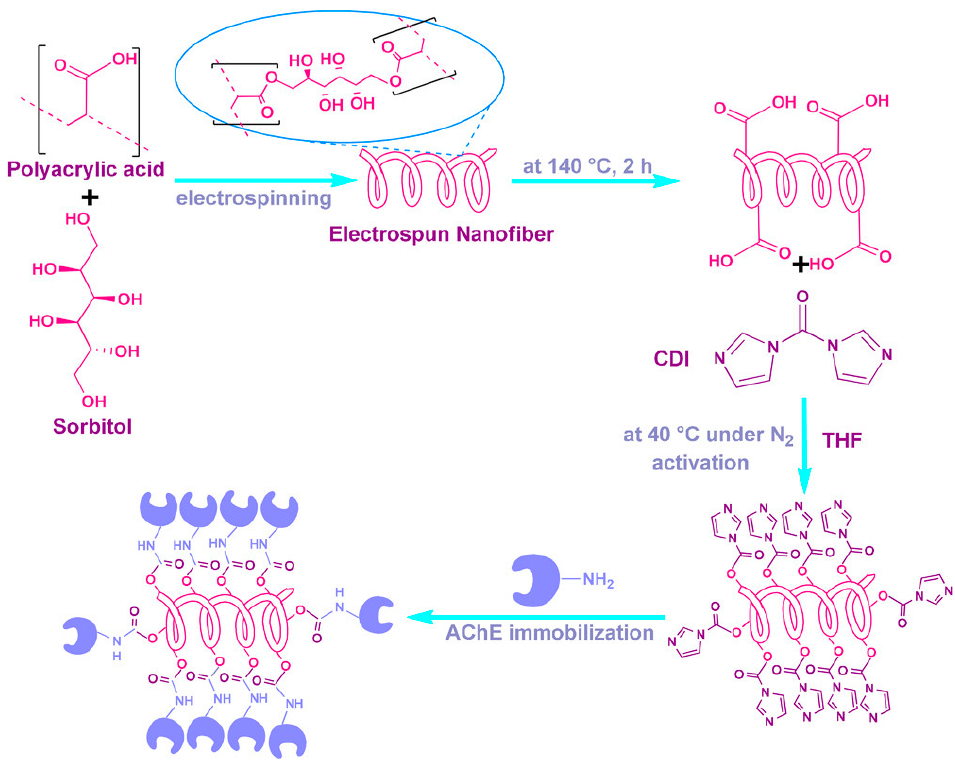
Figure 10. Schematic illustration of immobilization of AChE on electrospun nanofiber membrane [117]. Reprinted with permission from John Wiley & Sons, Inc. (Hoboken, NJ, USA). Reproduced with permission from [117]. Copyright John Wiley & Sons, Inc.,